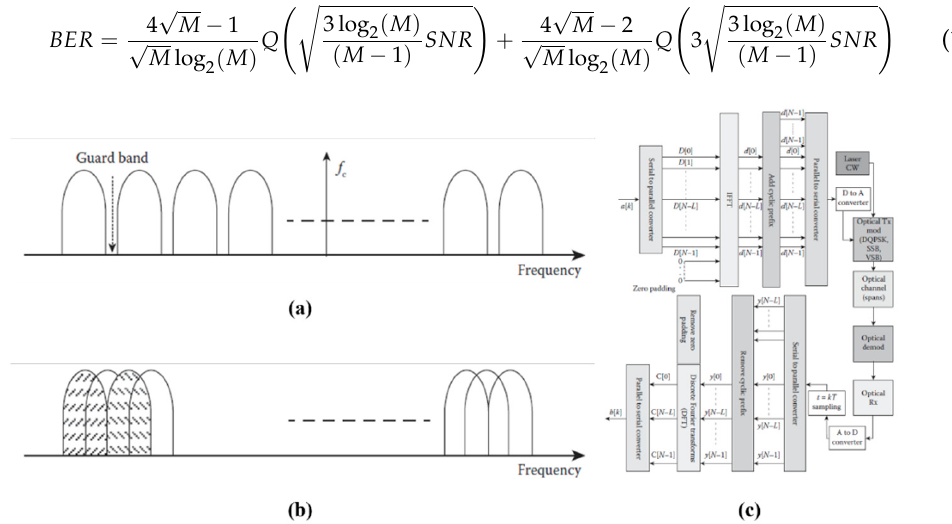
Figure 12. Spectrum of multicarrier modulation scheme ( a ) frequency division multiplexing and ( b ) OFDM, ( c ) a block diagram of OFDM system using N-point FFT and IFFT. From: [119], Copyright © 2015 and Imprint. Reproduced by permission of Taylor & Francis Group through PLSclear.